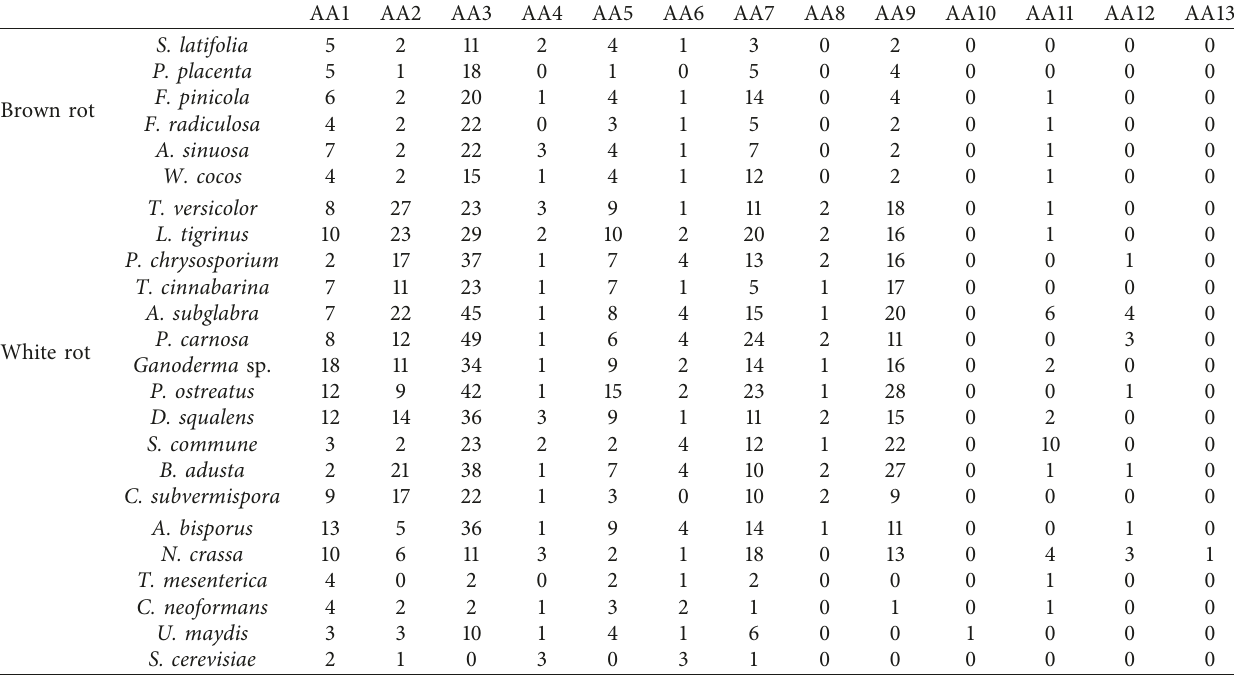
Table 2: Comparison of the number of AAs family of S. latifolia with those of other fungi.